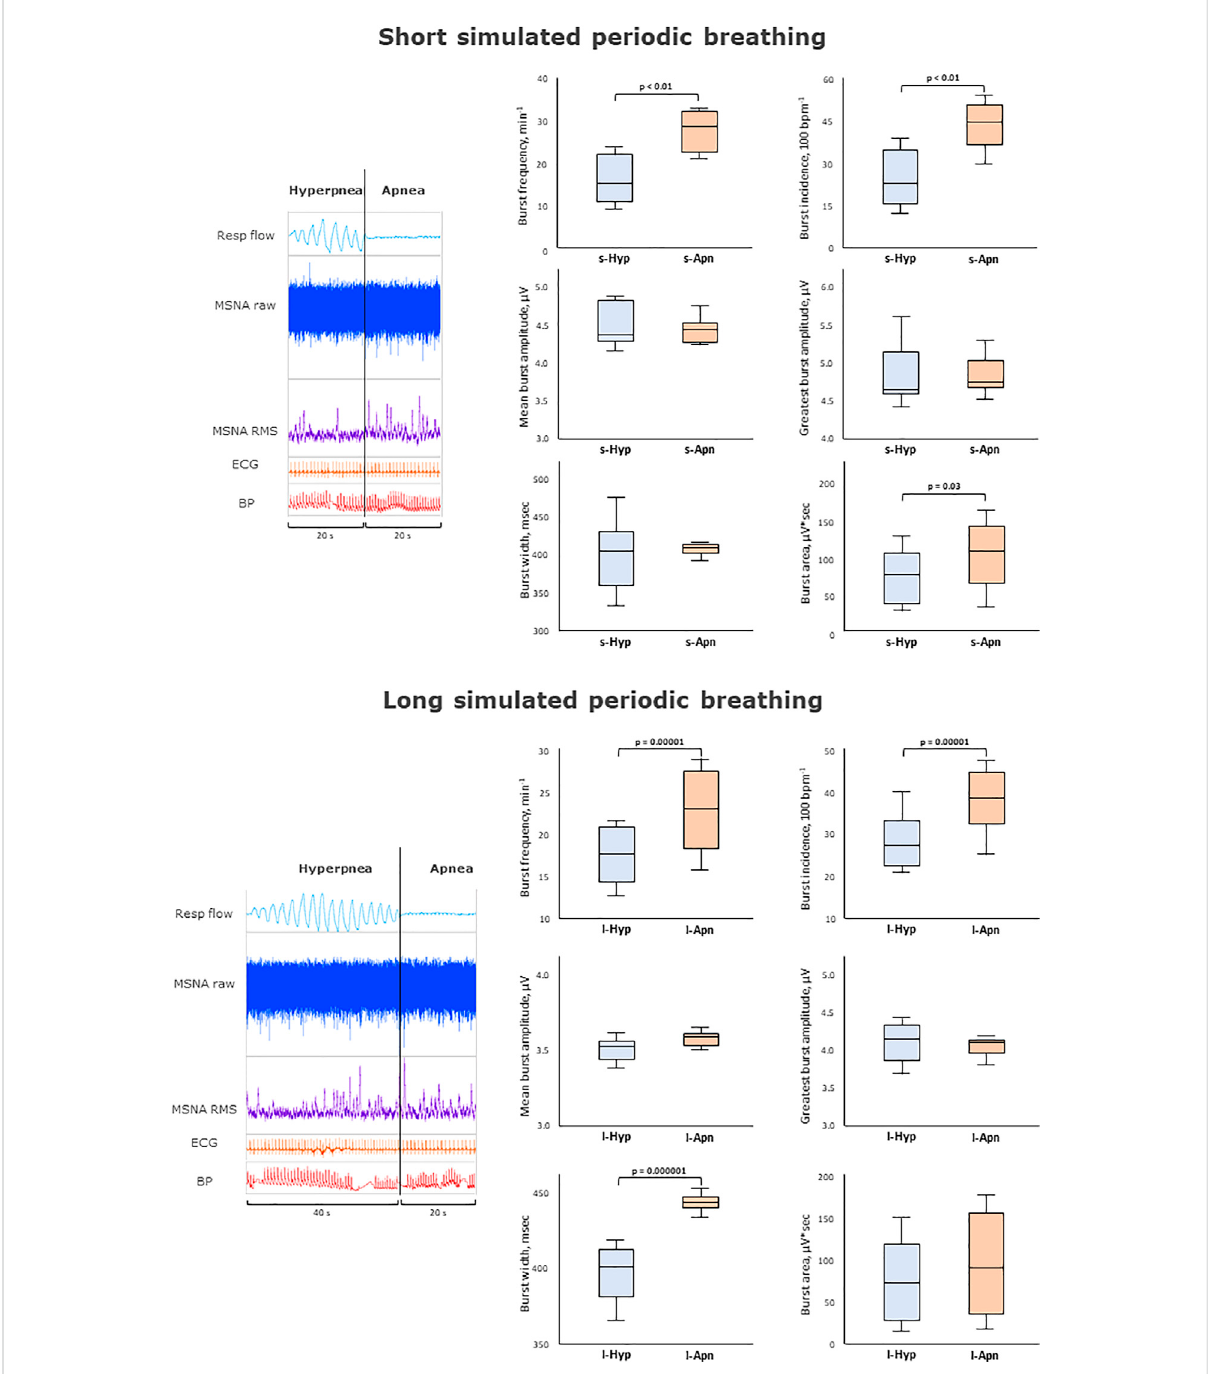
FIGURE 4 Impact of apneas compared to hyperpneas on muscle sympathetic nerve activity. Multi-unit recording of muscle SNA. RMS, root mean square, BP, blood pressure; Resp fl ow, respiratory fl